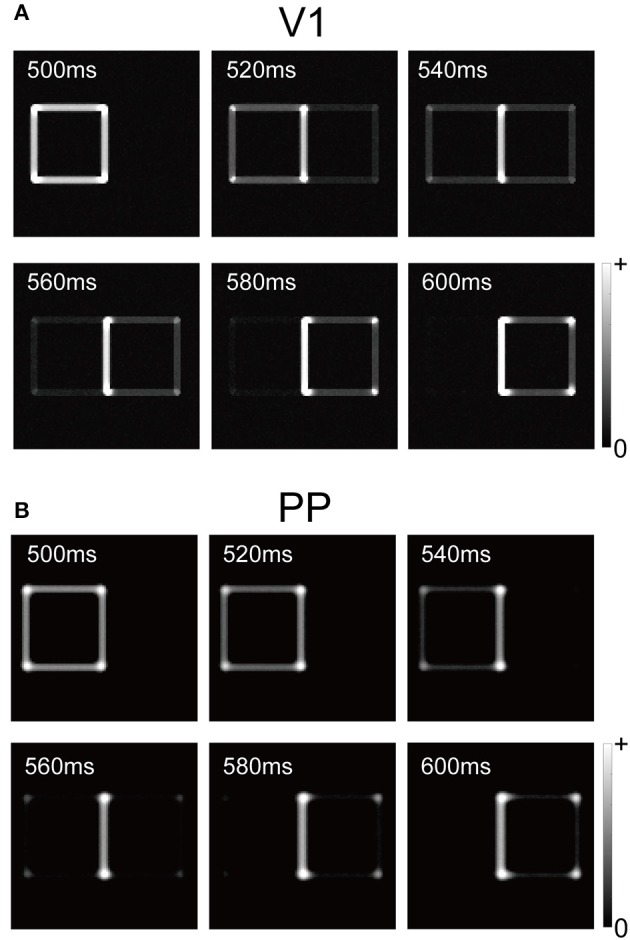
Responses of V1 and PP modules with respect to biological time (500–600 ms) for the stimulus corresponding to Figure 2B. We changed a left-BO white square to a right-BO black square at 500 ms (biological time). (A) Responses of the V1 module. All orientation factors in the V1 module were merged for visualization. Between 540 and 560 ms, the V1 module responded to the luminance contrasts for both the left- and right-BO squares. (B) Responses of the PP module. In contrast to V1 responses, regardless of right-BO black square presentation, the PP module did not exhibit sufficient response to the new figure until 580 ms in the simulation.